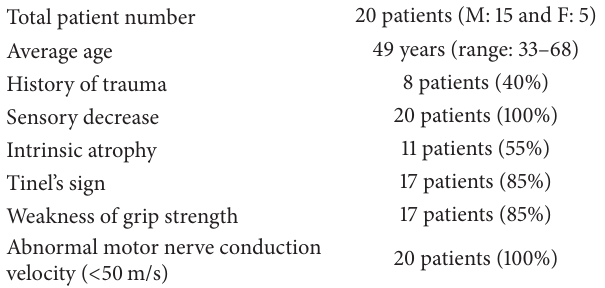
Table 1: Patient